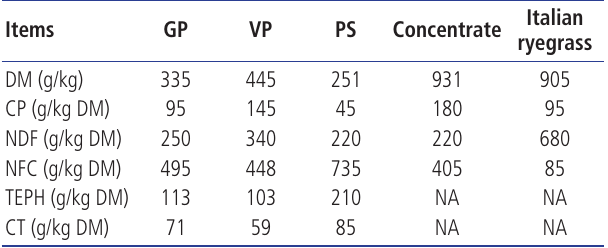
Table 1. Proximate composition of fruit byproducts (fresh matter) and feeds used for in vitro cultivation experiment Items GP VP